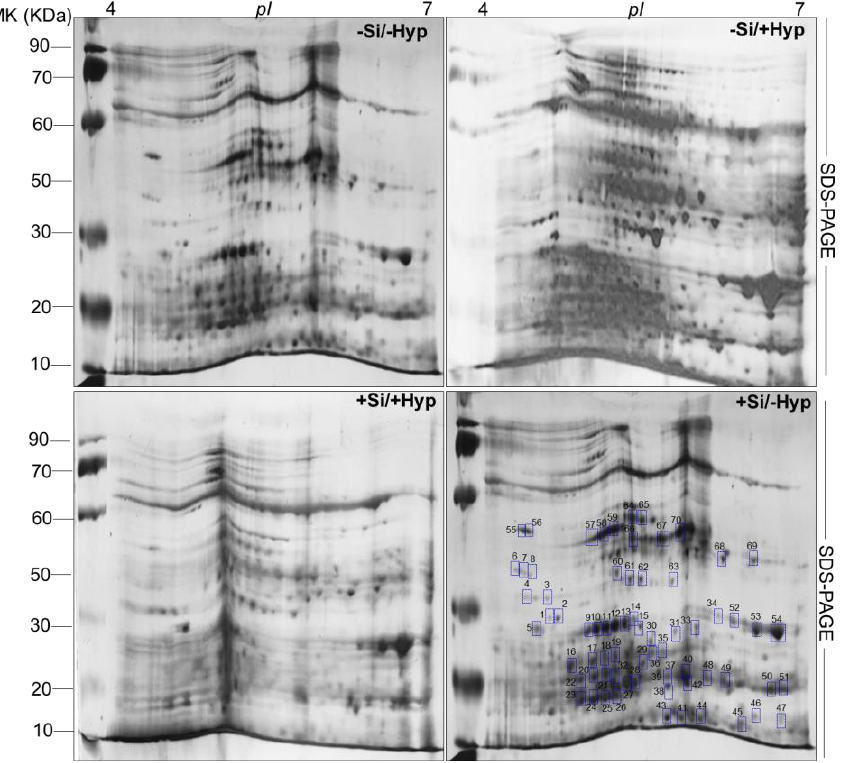
Figure 3. Representative second dimensional gels under hyperhydricity and silicon (Si) treatments (−Si/−Hyperhydricity; −Si/+Hyperhydricity; +Si/+Hyperhydricity; +Si/−Hyperhydricity) in shoot cultures of carnation ( Dianthus caryophyllus L.) grown in vitro .